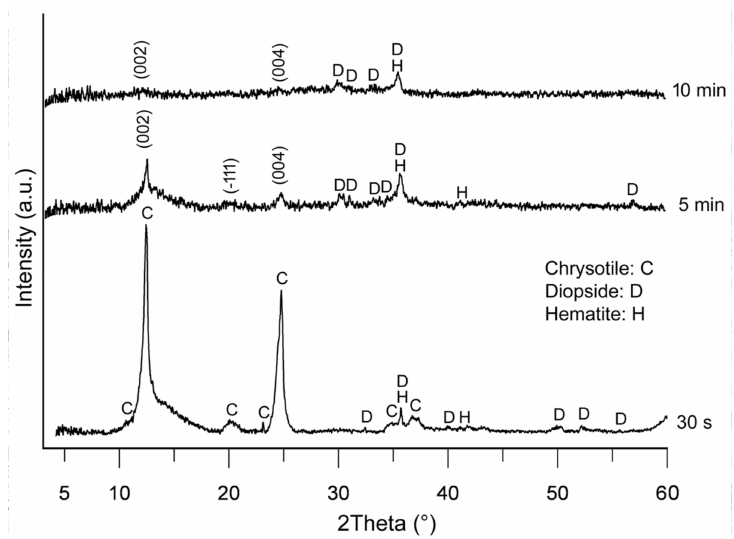
Figure 1. XRPD patterns of chrysotile recorded after 30 s, 5 min and 10 min of grinding